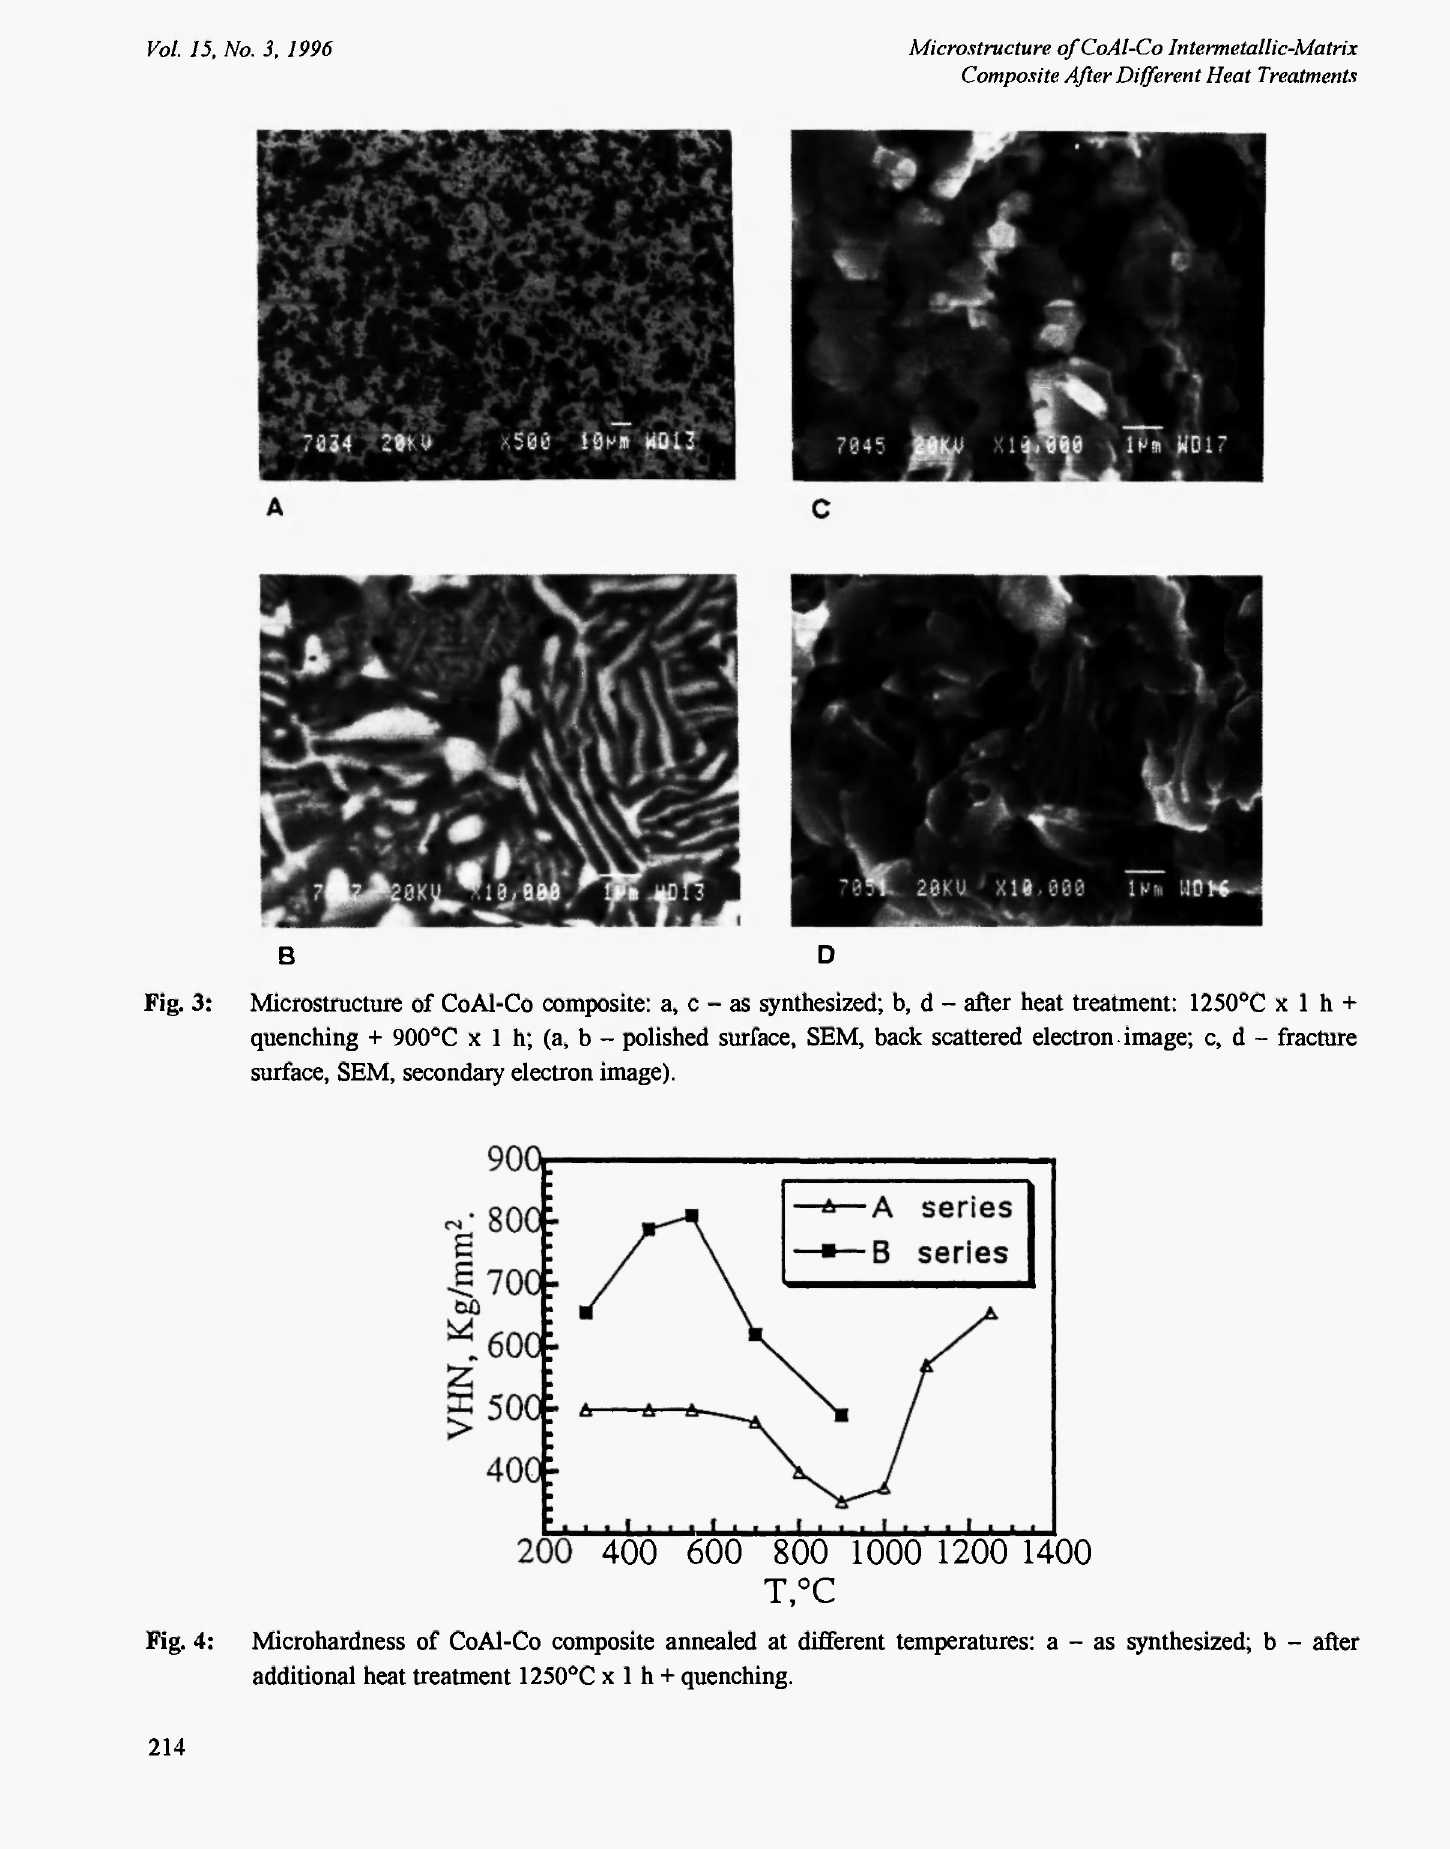
Fig. 4: Microhardness of CoAl-Co composite annealed at different temperatures: a - as synthesized; b - after additional heat treatment 1250°C χ 1 h +